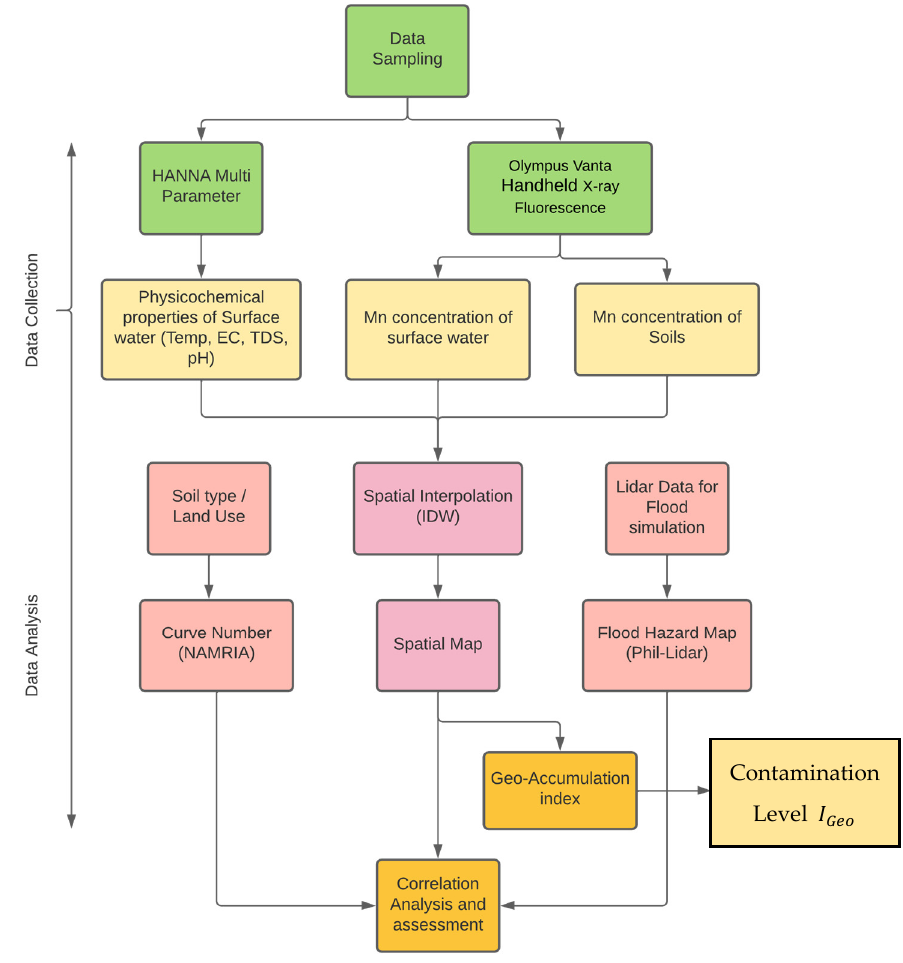
Figure 3. Research Diagram.